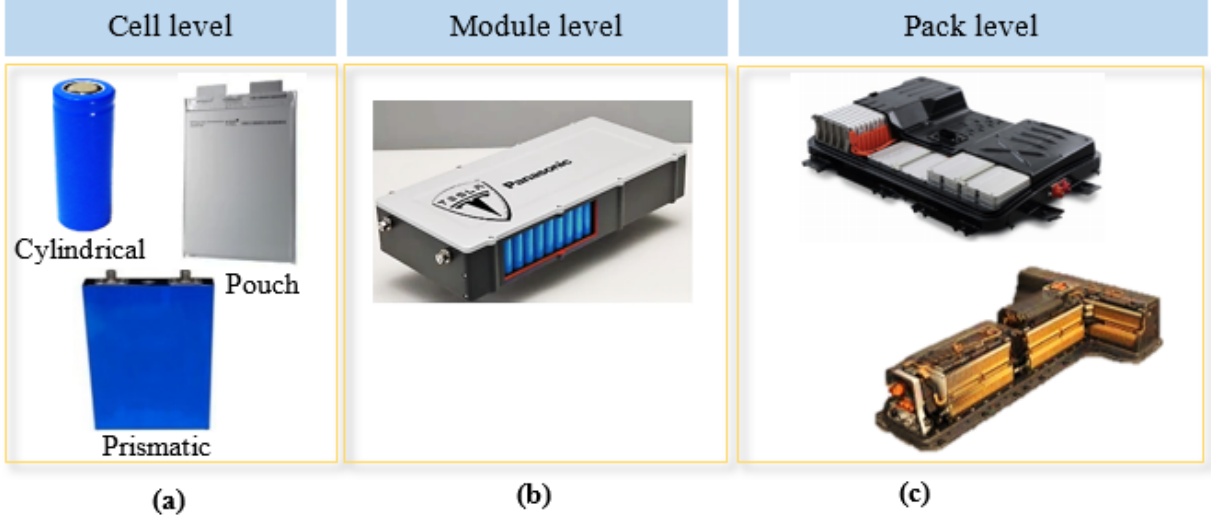
Figure 2. Types of Li-ion battery used as energy storage system in EVs: ( a ) Li-ion battery in cell level; ( b ) module level; and ( c ) pack level. The photos of pouch cell and module are from Sun et al. [15]. The photos of packs are from Warner [34], with permission from Elsevier.